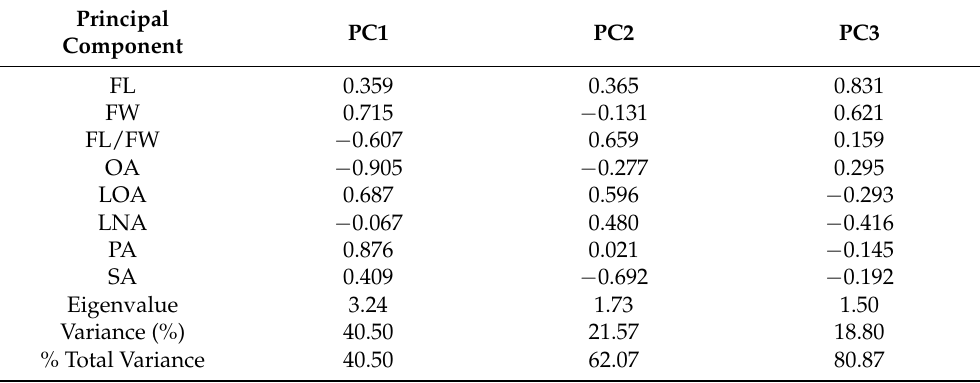
Figure 4. Principal components analysis (PCA) ordination diagram based on the morphological variables and fatty acid composition of Camellia oleifera . FL, fruit length; FW, fruit width; OA, oleic acid; LOA, linoleic acid; LNA, linolenic acid; PA, palmitic acid; SA, stearic acid. Different numbers represent the different sites that are shown in Table 1. Table 5. Principal component analysis loadings of the morphological and chemical parameters of Camellia oleifera and the contributions of the principal components to the total